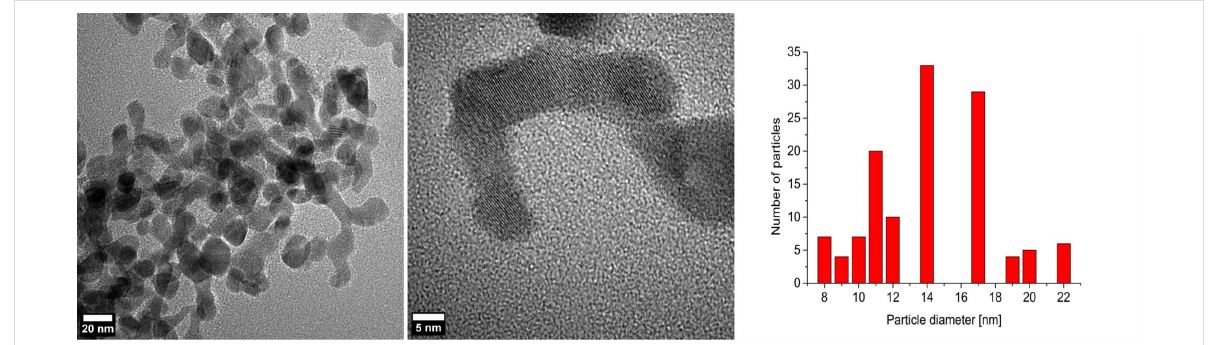
Figure 1: TEM images and particle size histogram (from 128 particles) of 1.0 wt % ErF 3 -NPs in [BMIm][BF 4 ] from Er(amd) 3 . Here and in the other TEM histogram evaluations the size measurements were done assuming approximately spherical particles. Differentiation of the overlapping particles was done with magnified images and with the help of the fine contrast.